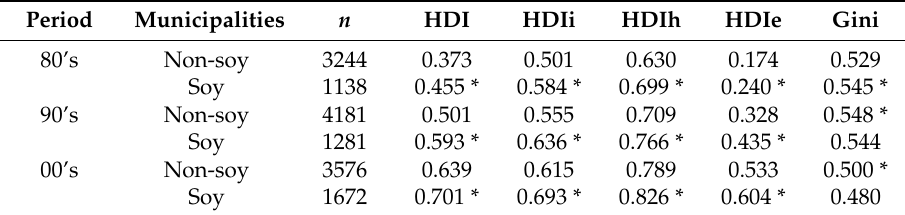
Table 1. The Human Development Index (HDI), its three components: income (HDIi), health (HDIh), education (HDIe), and the Gini coefficient for income for Brazil in the 80s, 90s and 00s. Statistical differences at 5% probability level are indicated by